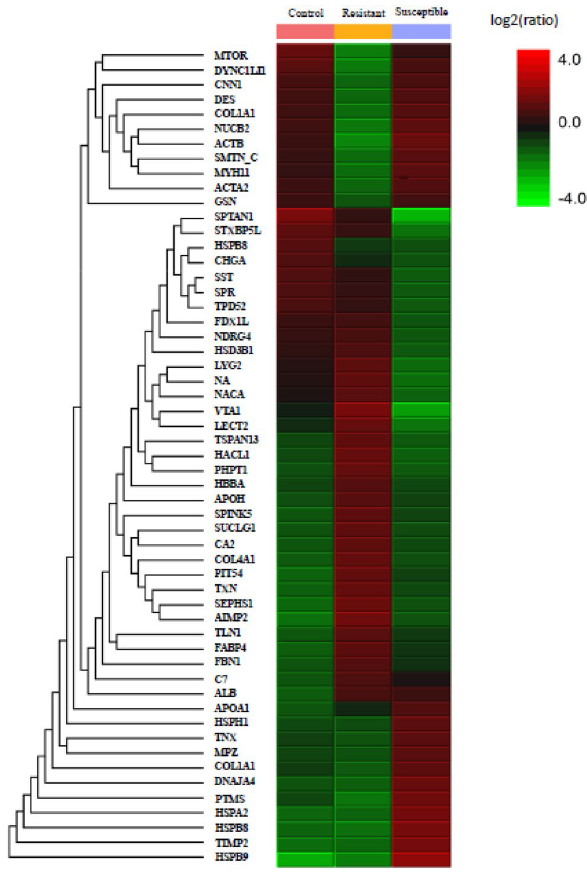
Figure 2. Heat map and hierarchical clustering depicting the differentially expressed proteins in the adrenal gland of male L2 strain Taiwan country chickens after acute heat stress by PEAKS Studio proteomics software (Version X, https:// www. bioin for. com/ peaks- studio/). The legend on the right indicates the color key for intermediate